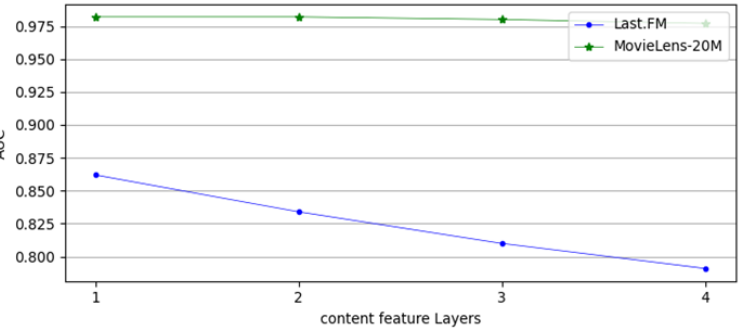
Figure 5. Influence of content feature layers on AUC.